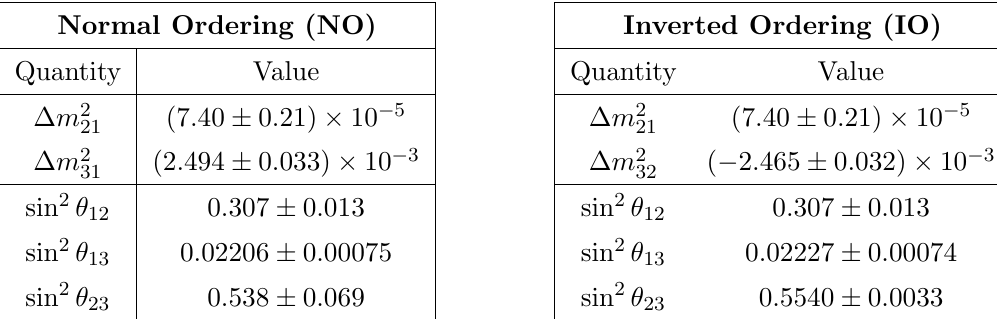
Table 5 . Experimental values of neutrino mass di(cid:11)erences and PMNS mixing angles for normal (NO) and inverted hierarchy (IO), taken from NuFIT 3.2 (2018) [14, 15].